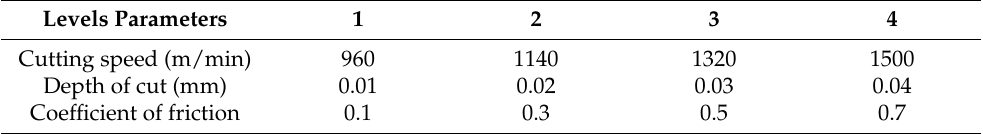
Table 1. Process parameters and their